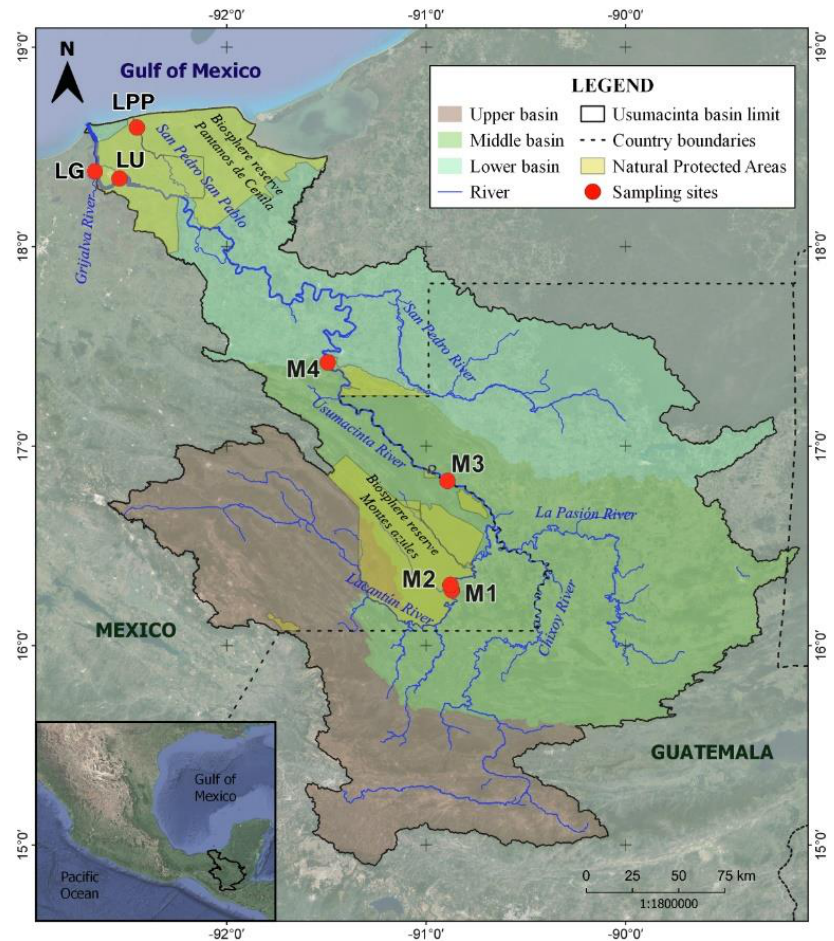
Figure 1. The Usumacinta River basin and sampling sites (elaborated using the INEGI database; datum: WGS84).